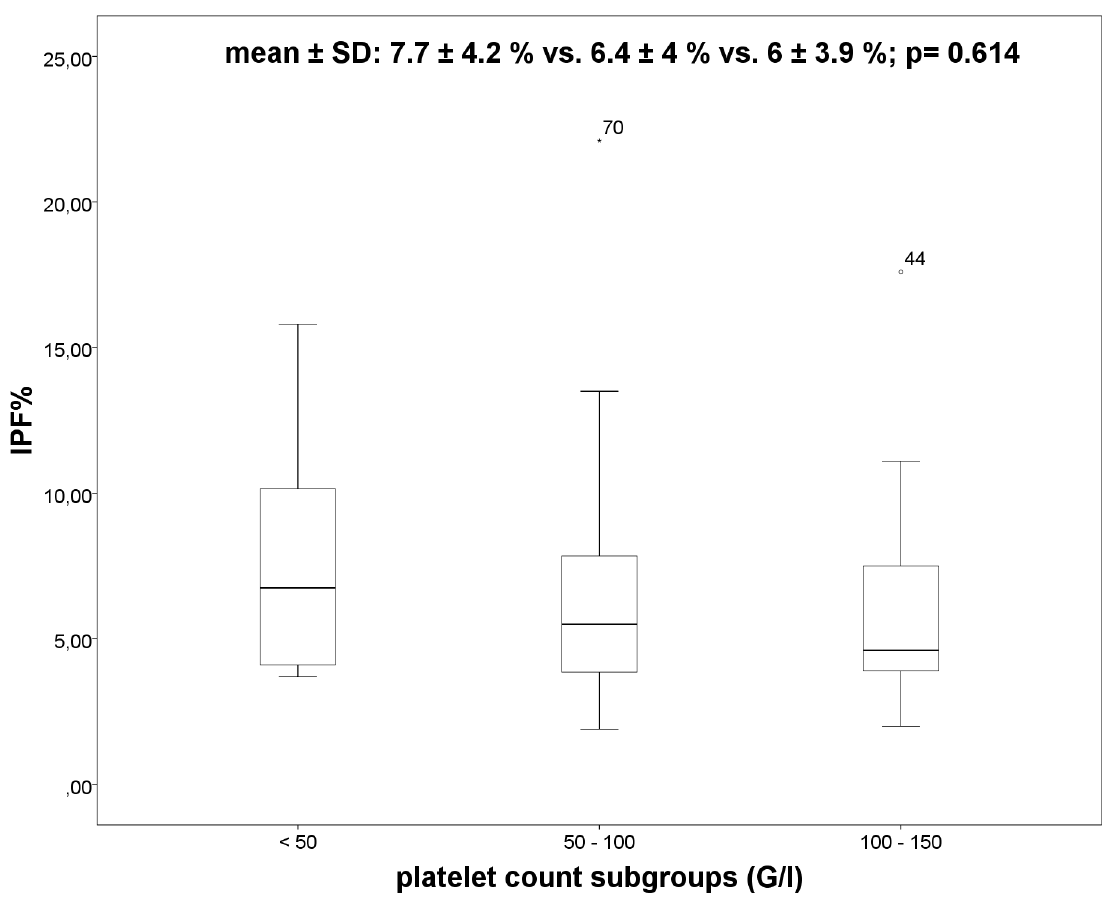
Fig 2. Boxplot: IPF% and the platelet count subgroups.